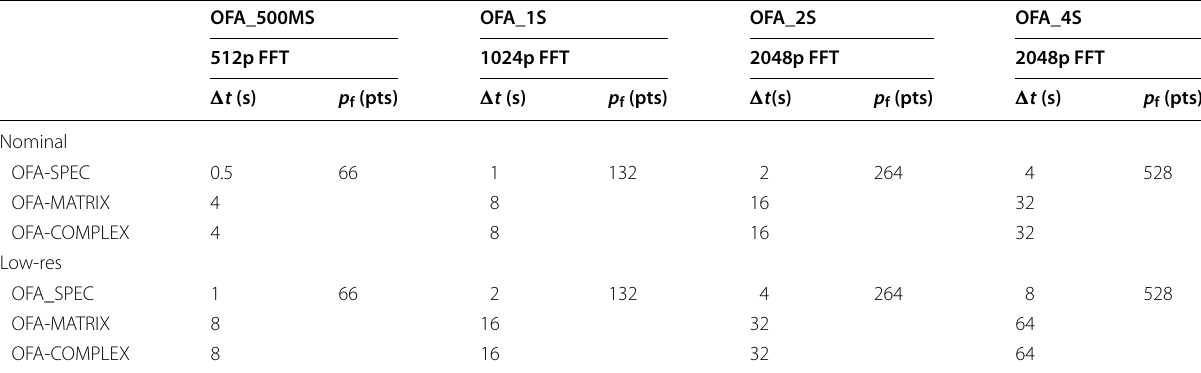
Table 4 Generation time intervals (cid:31) t and the numbers of frequency points p f in the four operation modes of the